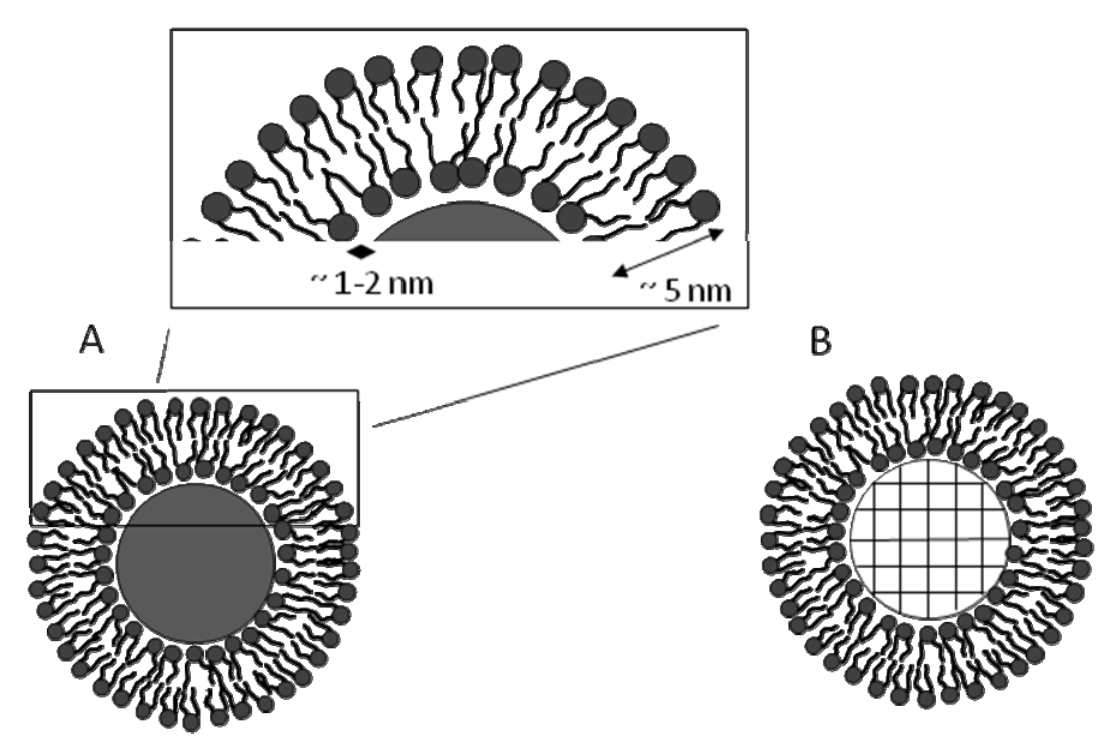
Figure 4. Schematic of a supported lipid bilayer (SLBs) which has a thickness of 5 nm with an underlying 1-2 nm water layer on (A) a solid microsphere, and (B) a porous